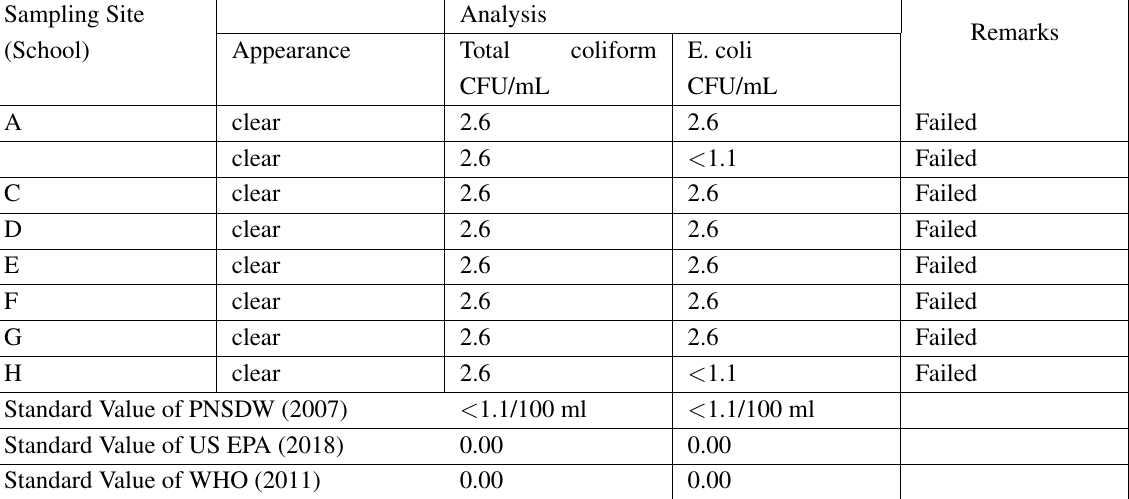
Table 1. Themicrobiological test result of water from WVMs among selected public schools in Cebu City Sampling Site